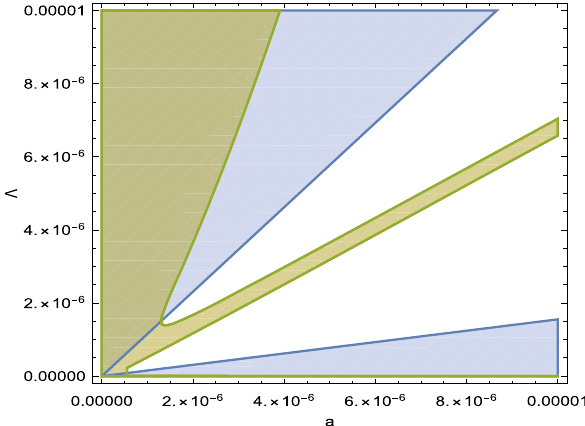
Fig. 1 Considering the single-field inflation case, we display in units of Planck mass the ((cid:16), a ) space that is allowed by the constraints on n s and (cid:17) R that arise from the Planck satellite data. Outside the blue and green subregions values of (cid:16) and a are compatible with the Planck